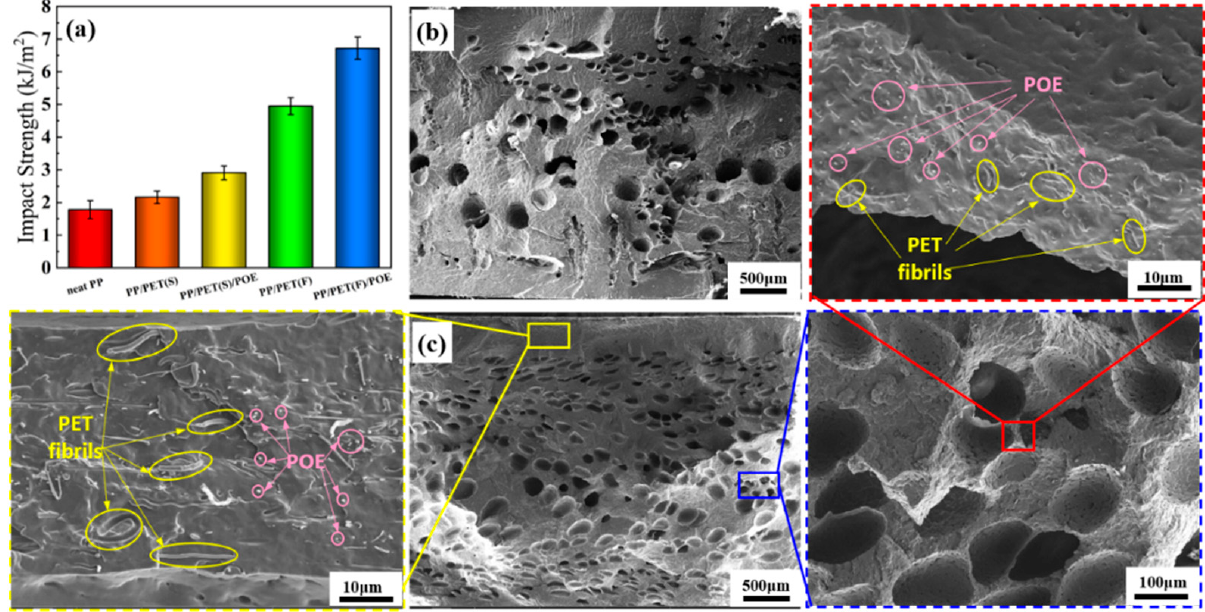
Figure 13. Impact test results: ( a ) Izod impact strength; ( b ) and ( c ) are the impact fracture surface morphology of neat PP and PP/PET(F)/POE foam, respectively.